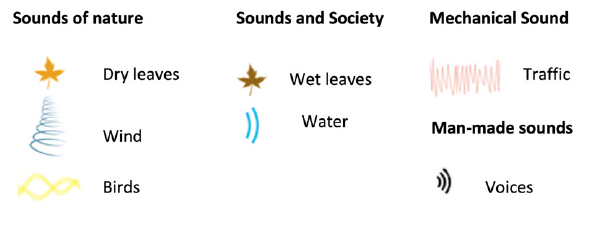
Figure 6: Legenda of symbols of Figures